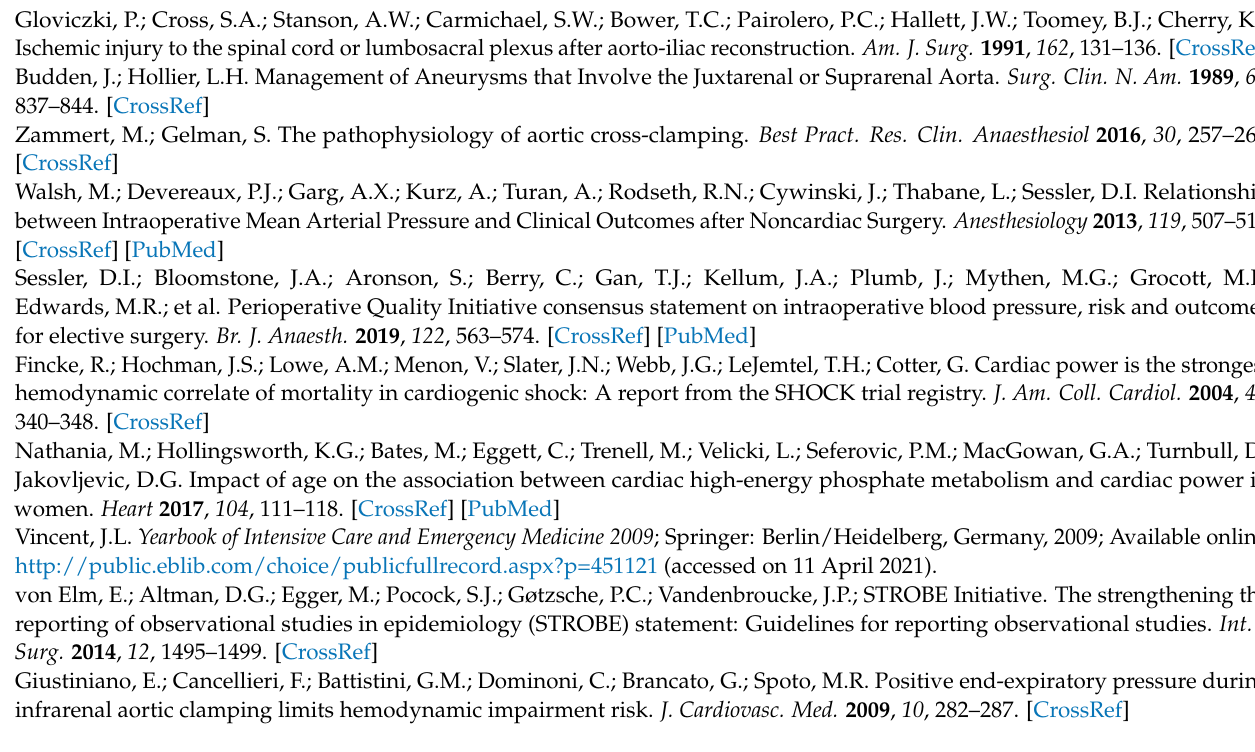
age; Table S1: Multiple correlations of CPI and CPI variation with cardiovascular risk factors; Table S2: Intra-operative fluid therapy; Table S3: Postoperative and outcome data; Table S4: Effect of PEEP level during aortic clamping on hemodynamics and